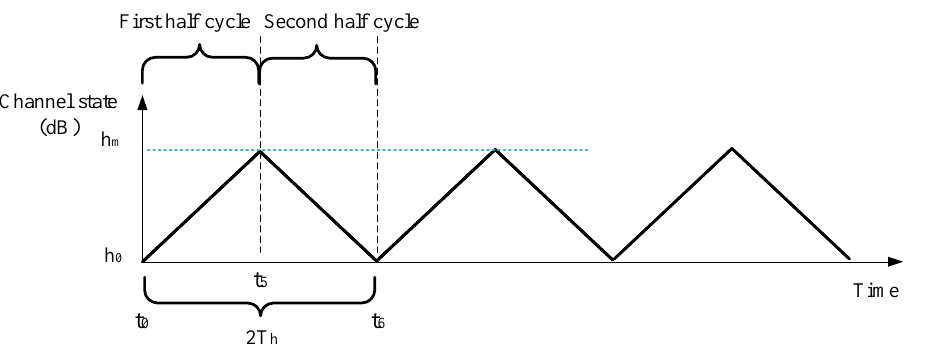
Figure 8. A linearly varying channel state